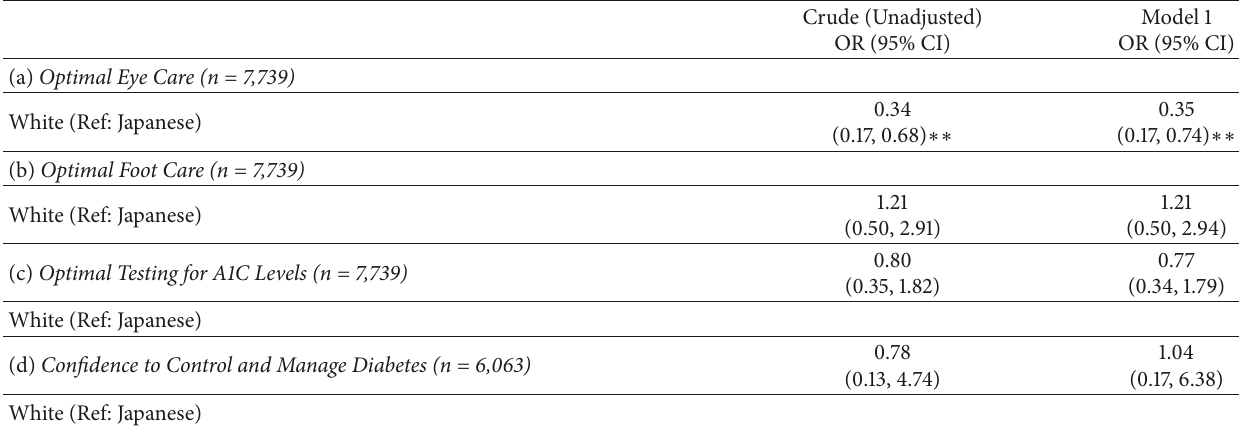
Table 4: Logistic regression of diabetes management variables for non-Hispanic White vs. Japanese-American adults with BMI <